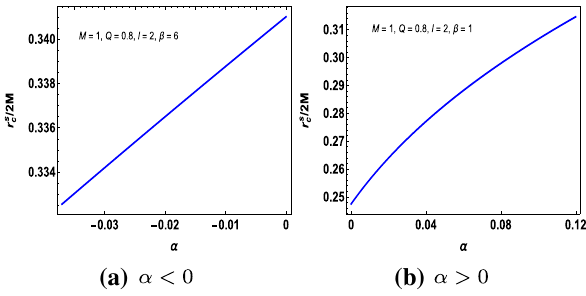
Fig. 6 The critical size r s c of specific heat a for negative α and b for positive α in the novel 4D EGB gravity